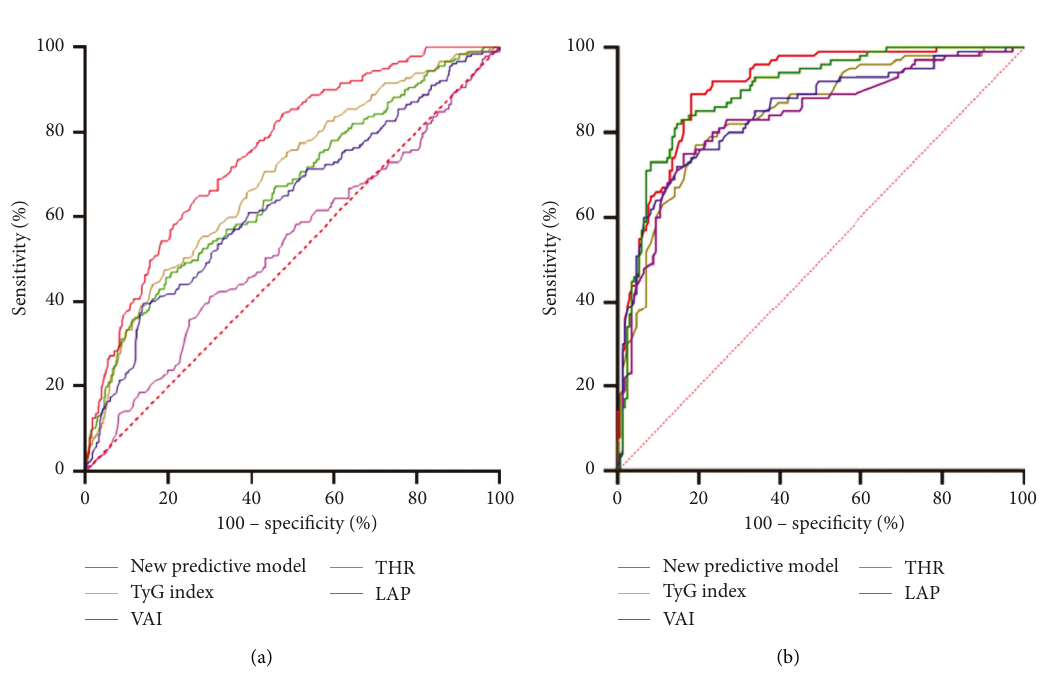
Figure 2: ROC curve of each index for predicting IR. (a) ROC curve for predicting IR in patients with T2DM. (b) ROC curve for predicting IR in healthy subjects. ROC: receiver operating characteristic, IR: insulin resistance, T2DM: type 2 diabetes mellitus, triglyceride to high- density lipoprotein cholesterol ratio, and LAP: lipid accumulation